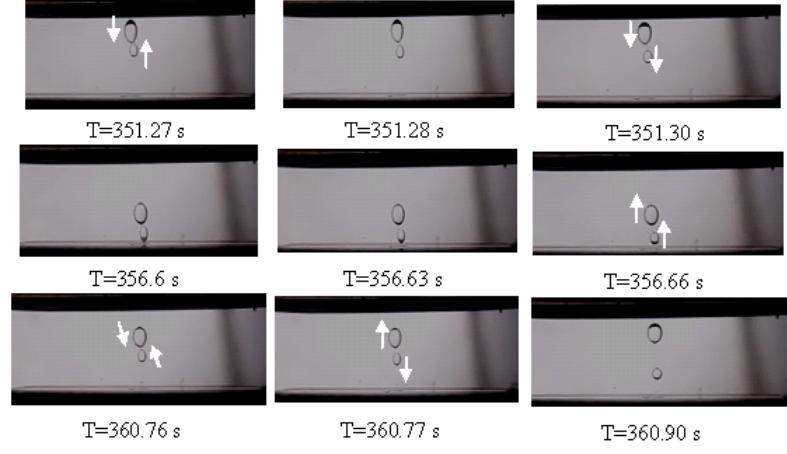
Figure 8. Repelling phenomenon of two opposite charge drops at the top, bottom and middle positions (Ca E = 0 .